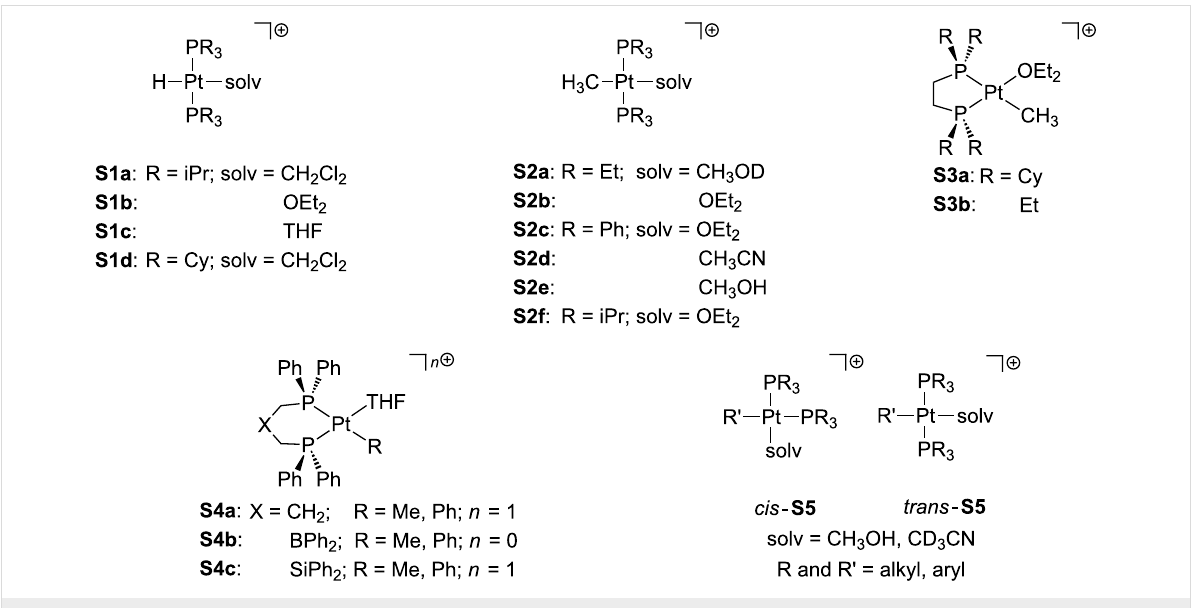
Figure 10: Phosphine-based solvento Pt(II) complexes.